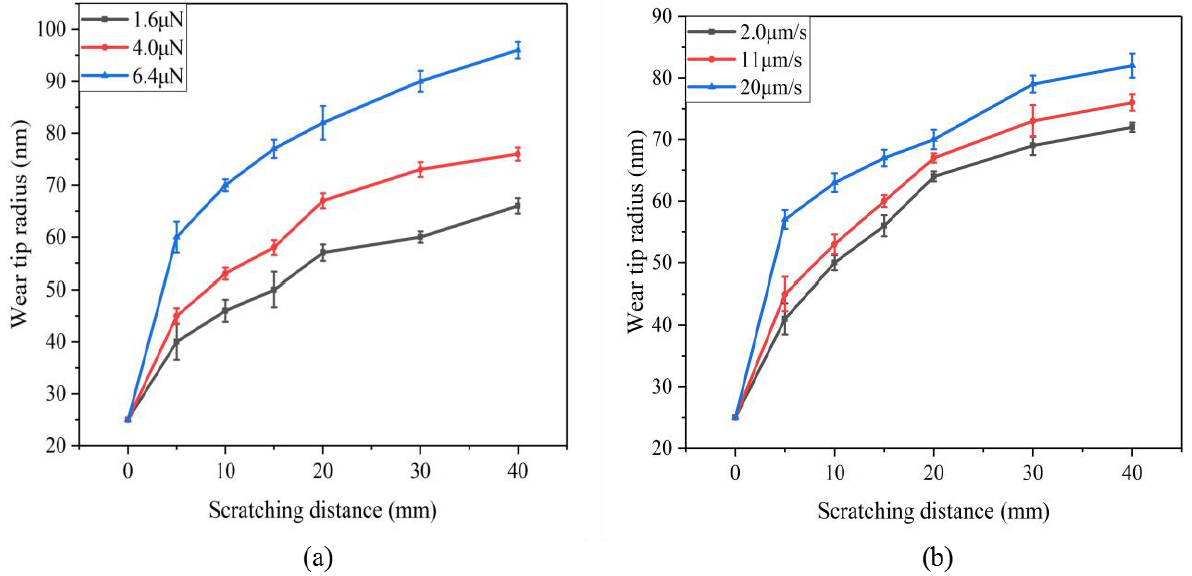
Figure 6. Relationship between scratching distance and wear tip radius: ( a ) different normal load levels; ( b ) different scratching speed levels.